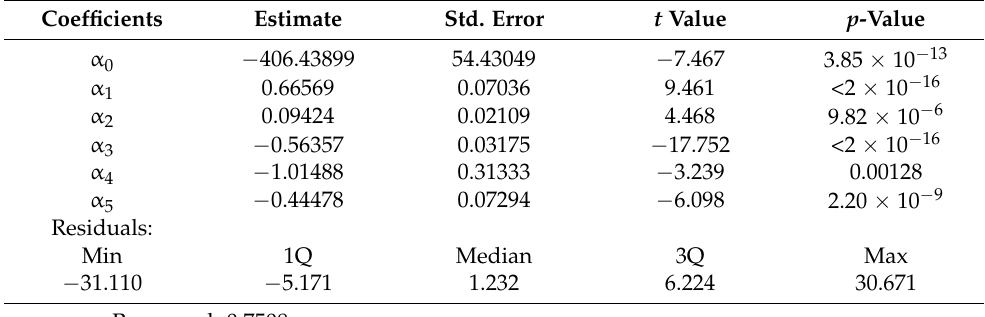
Table 2. The table contains the summary of the model described in Equation (3), adjusted to the dataset with all records. We can see the estimated values and the standard errors of the coefficients, the test statistics and p -values of their significance tests (for i = 0,1, . . . ,5, the null hypothesis is α i = 0), the statistics of the residuals and the goodness of